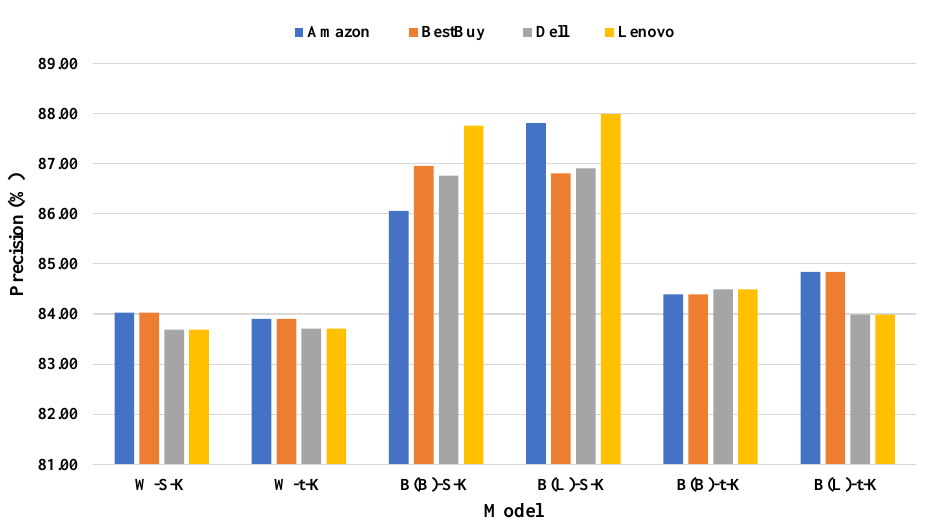
Figure 5. The comparison between the achieved results from applying proposed models variants on different datasets, where K = 150.